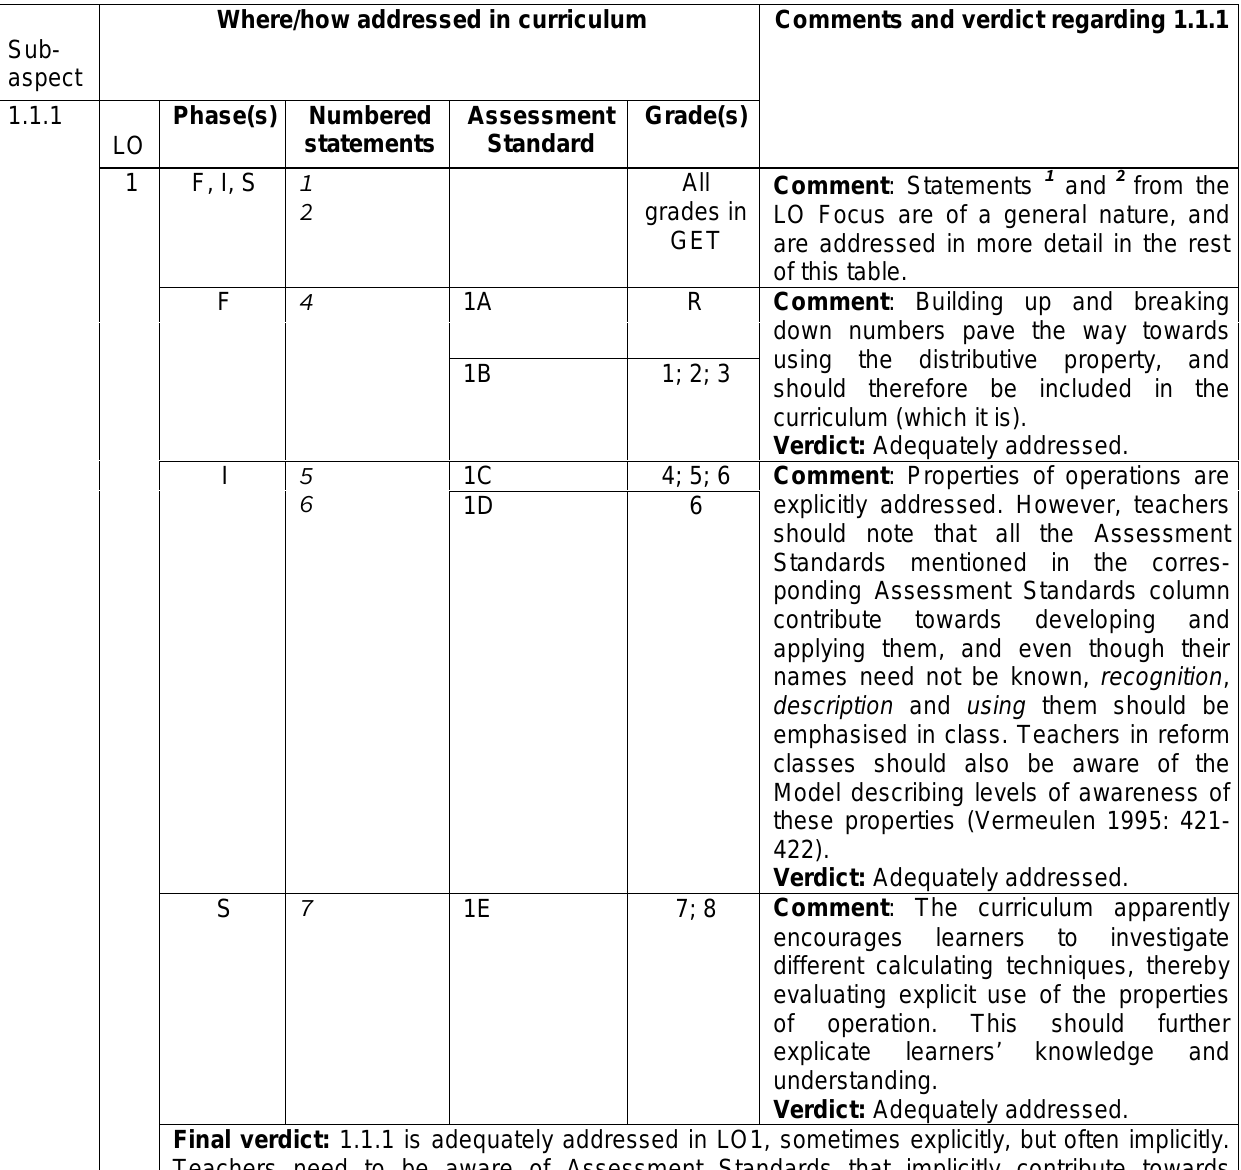
Table 1. Aspect 1: enable learners to experience and appreciate algebra as generalised arithmetic